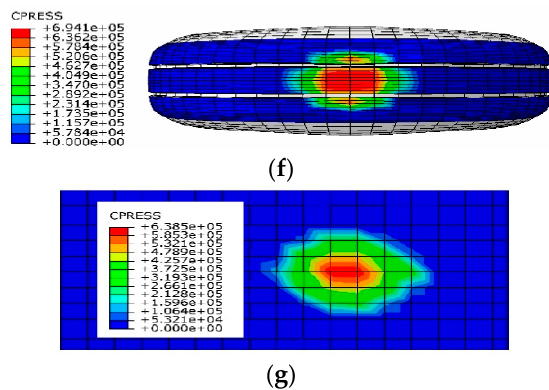
Figure 4. Stress and strain nephogram of the 3D model of pneumatic tire-asphalt pavement contact. ( a ) 3D Tire-pavement contact model, ( b ) Mises equivalent stress nephogram of the inflated tire, ( c ) Mises equivalent stress nephogram of the inflated tire rubber materials, ( d ) Deformation nephogram of the inflated tire rubber materials, ( e ) Deformation nephogram of the inflated tire, ( f ) Pressure distribution of tire tread on the contact region, ( g ) Pressure distribution of Pavement surface on the contact region.